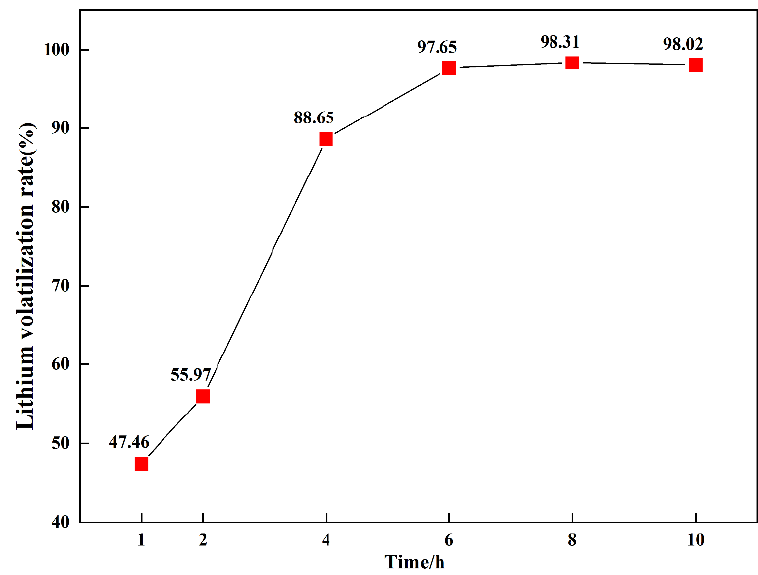
Figure 12. Reduction rates of lithium with varying reduction times.